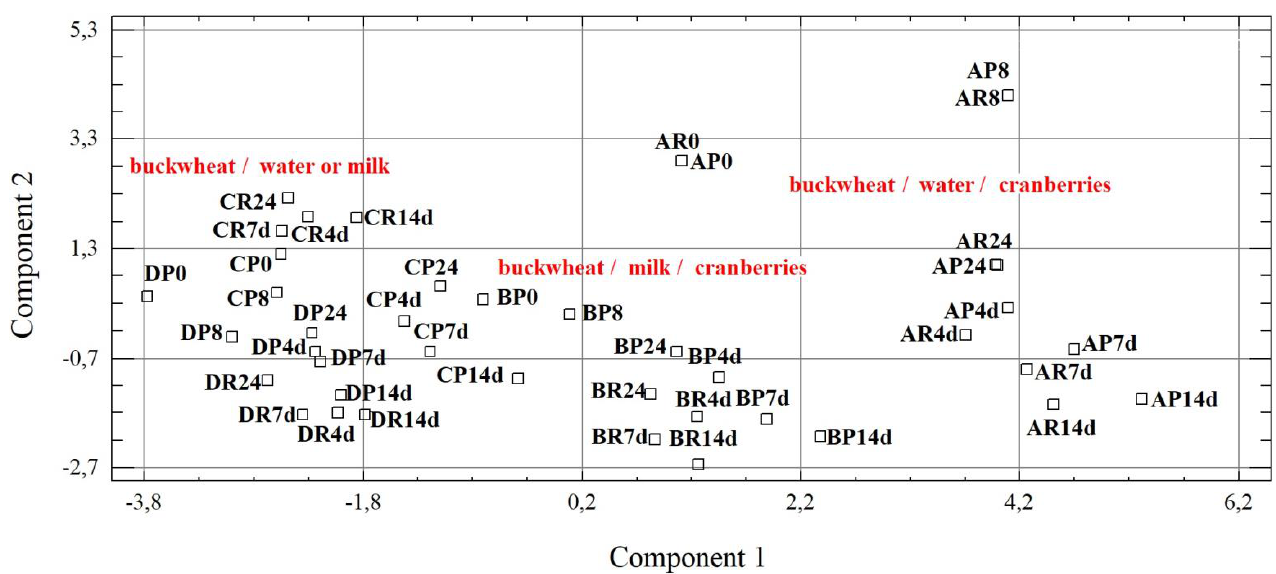
Figure 4. Principal component analysis graph of the studied samples at different fermentation terms and storage: AP0-AP14d: buckwheat/water/cranberries/ L. plantarum HM1; AR0-AR14d: buckwheat/water/cranberries/ L. rhamnosus GG; BP0-BP14d: buckwheat/milk/cranberries/ L. plantarum HM1; BR0-BR14d: buckwheat/milk/cranberries/ L. rhamnosus GG; CP0-CP14d: buckwheat/water/ L. plantarum HM1; CR0-CR14d: buckwheat/water/ L. rhamnosus GG; DP0-DP14d: buckwheat/milk/ L. plantarum HM1; DR0-DR14d: buckwheat/milk/ L. rhamnosus GG during experimental period 0–14 days.